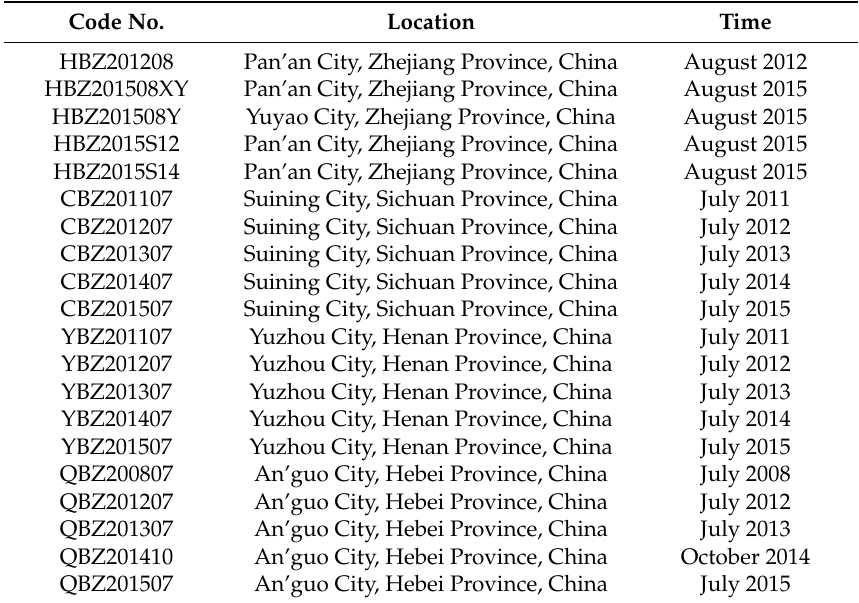
Table 6. Samples of 20 batches of Angelicae dahuricae Radix analyzed in the present study. Code No. Location